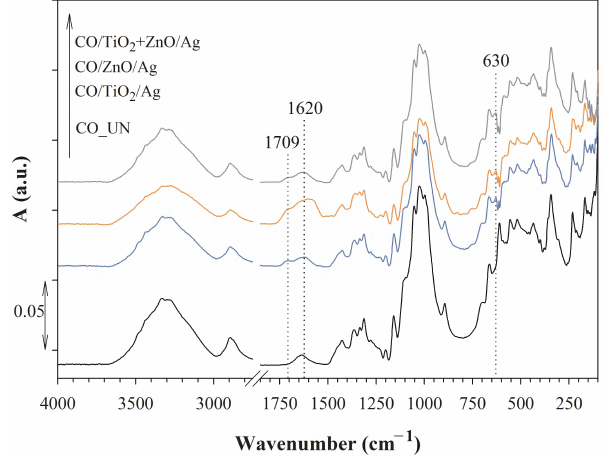
Figure 2. IR ATR spectra of untreated (CO_UN) and chemically modified CO/TiO 2 /Ag, CO/ZnO/Ag and CO/TiO 2 + ZnO/Ag samples.